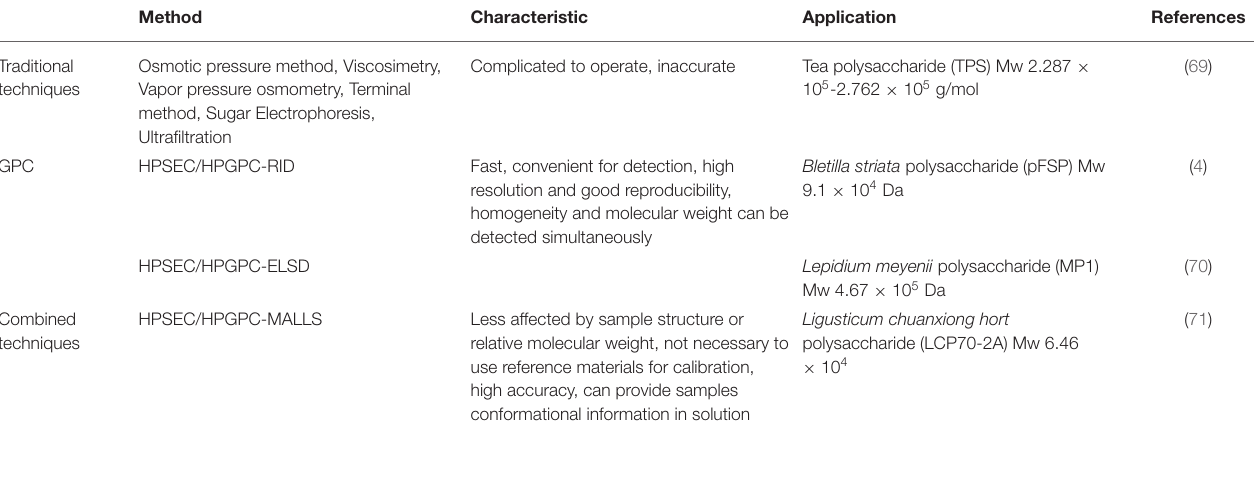
TABLE 1 | Comparison of determination methods of molecular weight.